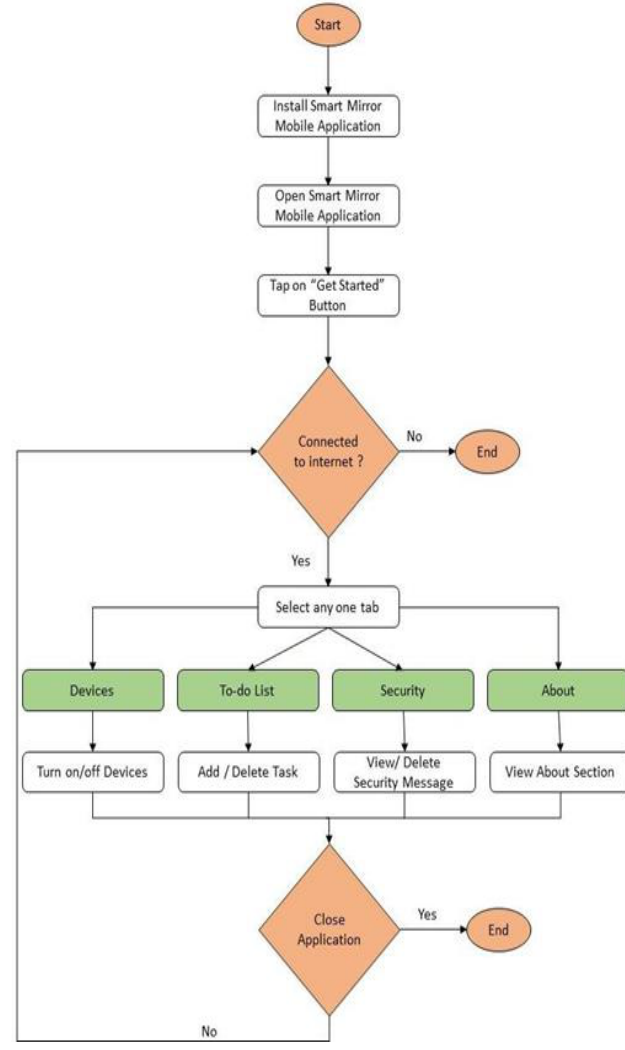
Figure 3. Flow Chart Diagram of Mobile